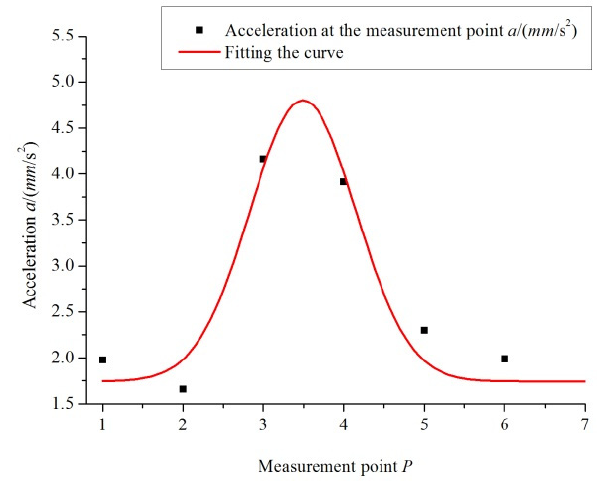
Figure 25. Peak acceleration at measurement points 1–7.